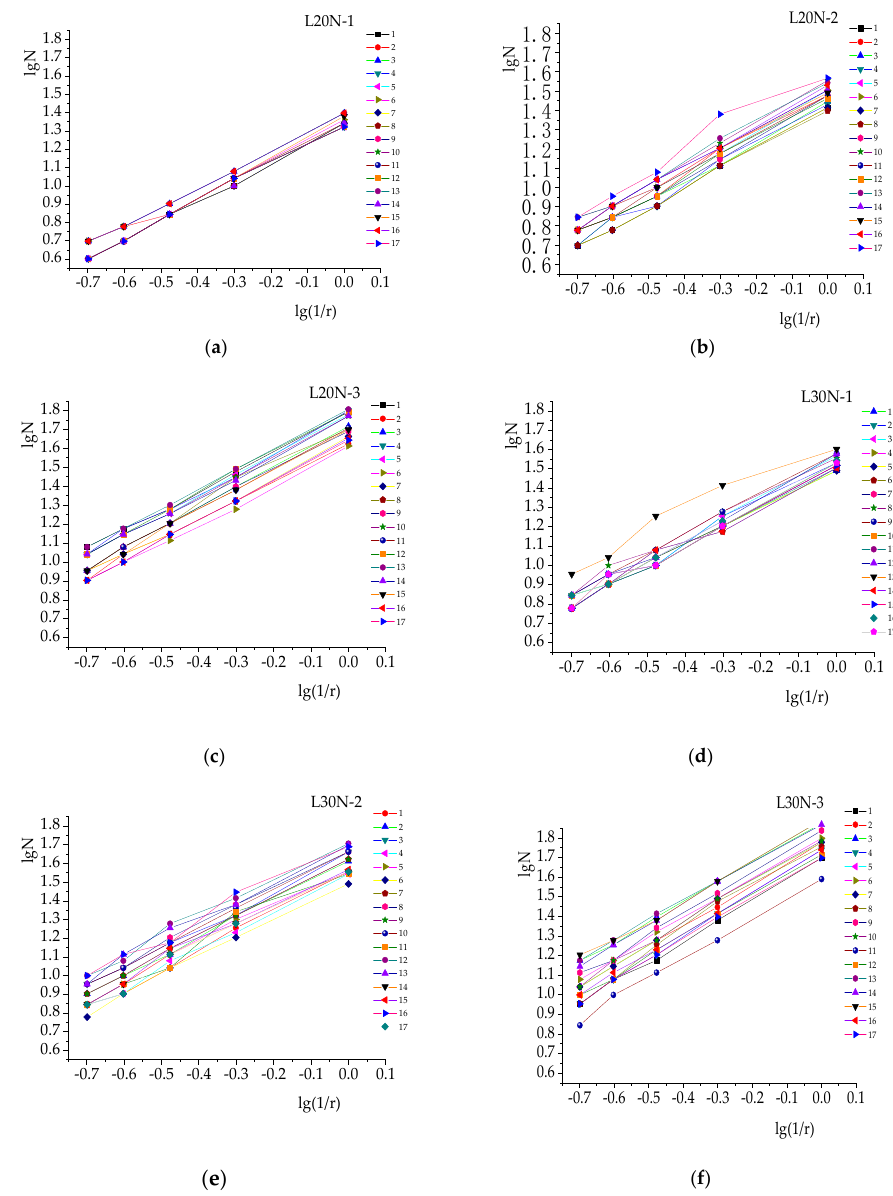
Figure 5. Analysis of fractal characteristics (relationship between lg(1/ r ) and lg N ) of the different specimens: ( a ) L20N-1; ( b ) L20N-2; ( c ) L20N-3; ( d ) L30N-1; ( e ) L30N-2; ( f ) L30N-3.